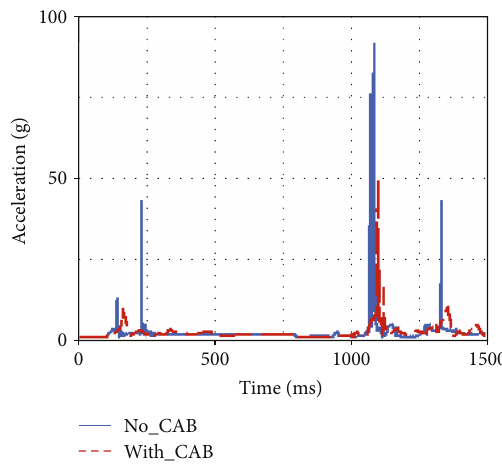
Figure 7: Head resultant